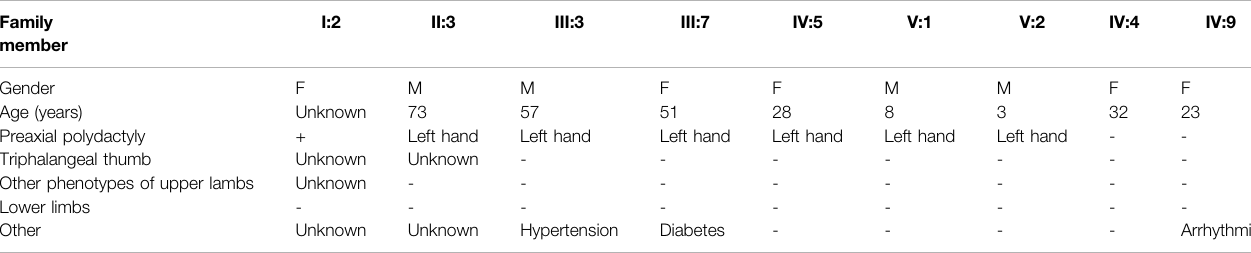
TABLE 1 | Phenotypes of parts family members in PPD001 family. Family